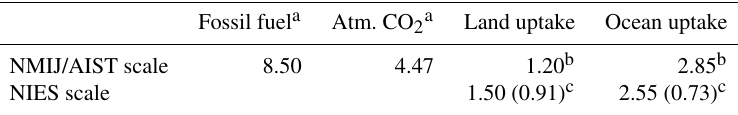
Table 5. Land biospheric and oceanic CO 2 uptakes from 2000 to 2016 reported by Tohjima et al. (2019) using the NMIJ/AIST and NIES O 2 / N 2 scales (see text for more details).